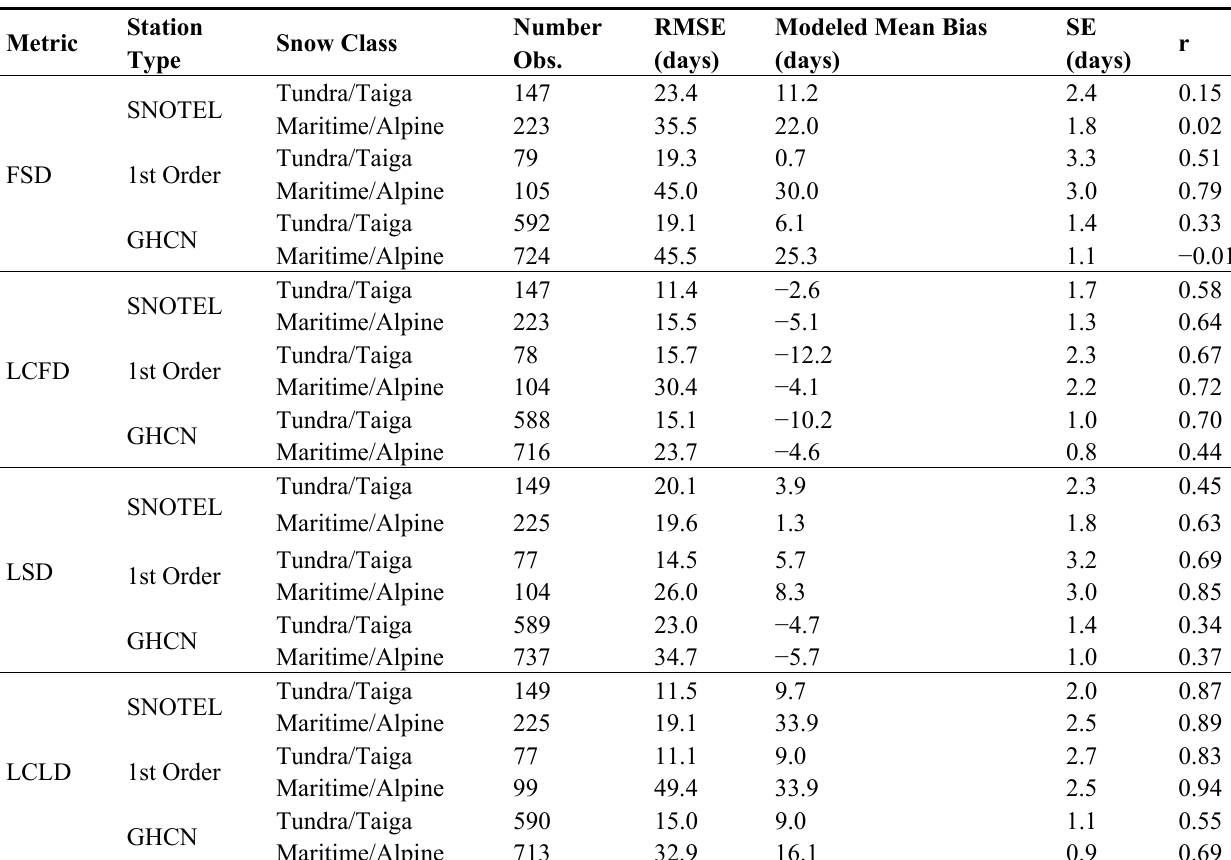
Table 3. RMSE, multivariate mean bias and standard error (SE) from the general linear model, and Pearson’s correlation coefficients (r) between metrics and in situ dates from weather stations for snow onset and melt during